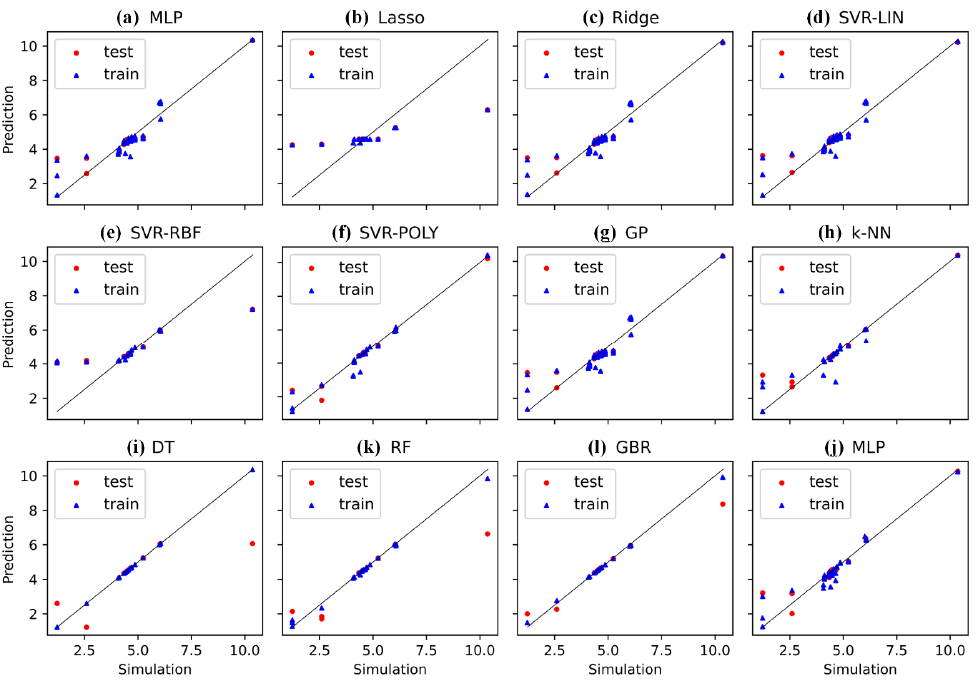
Figure 6. Simulation versus predicted values for diffusion coefficient in Poiseuille flow model of the LJ fluid, being the output of 12 different algorithms ( a – l ). Data points include both training and test data. The 45° identity line denotes the perfect match.